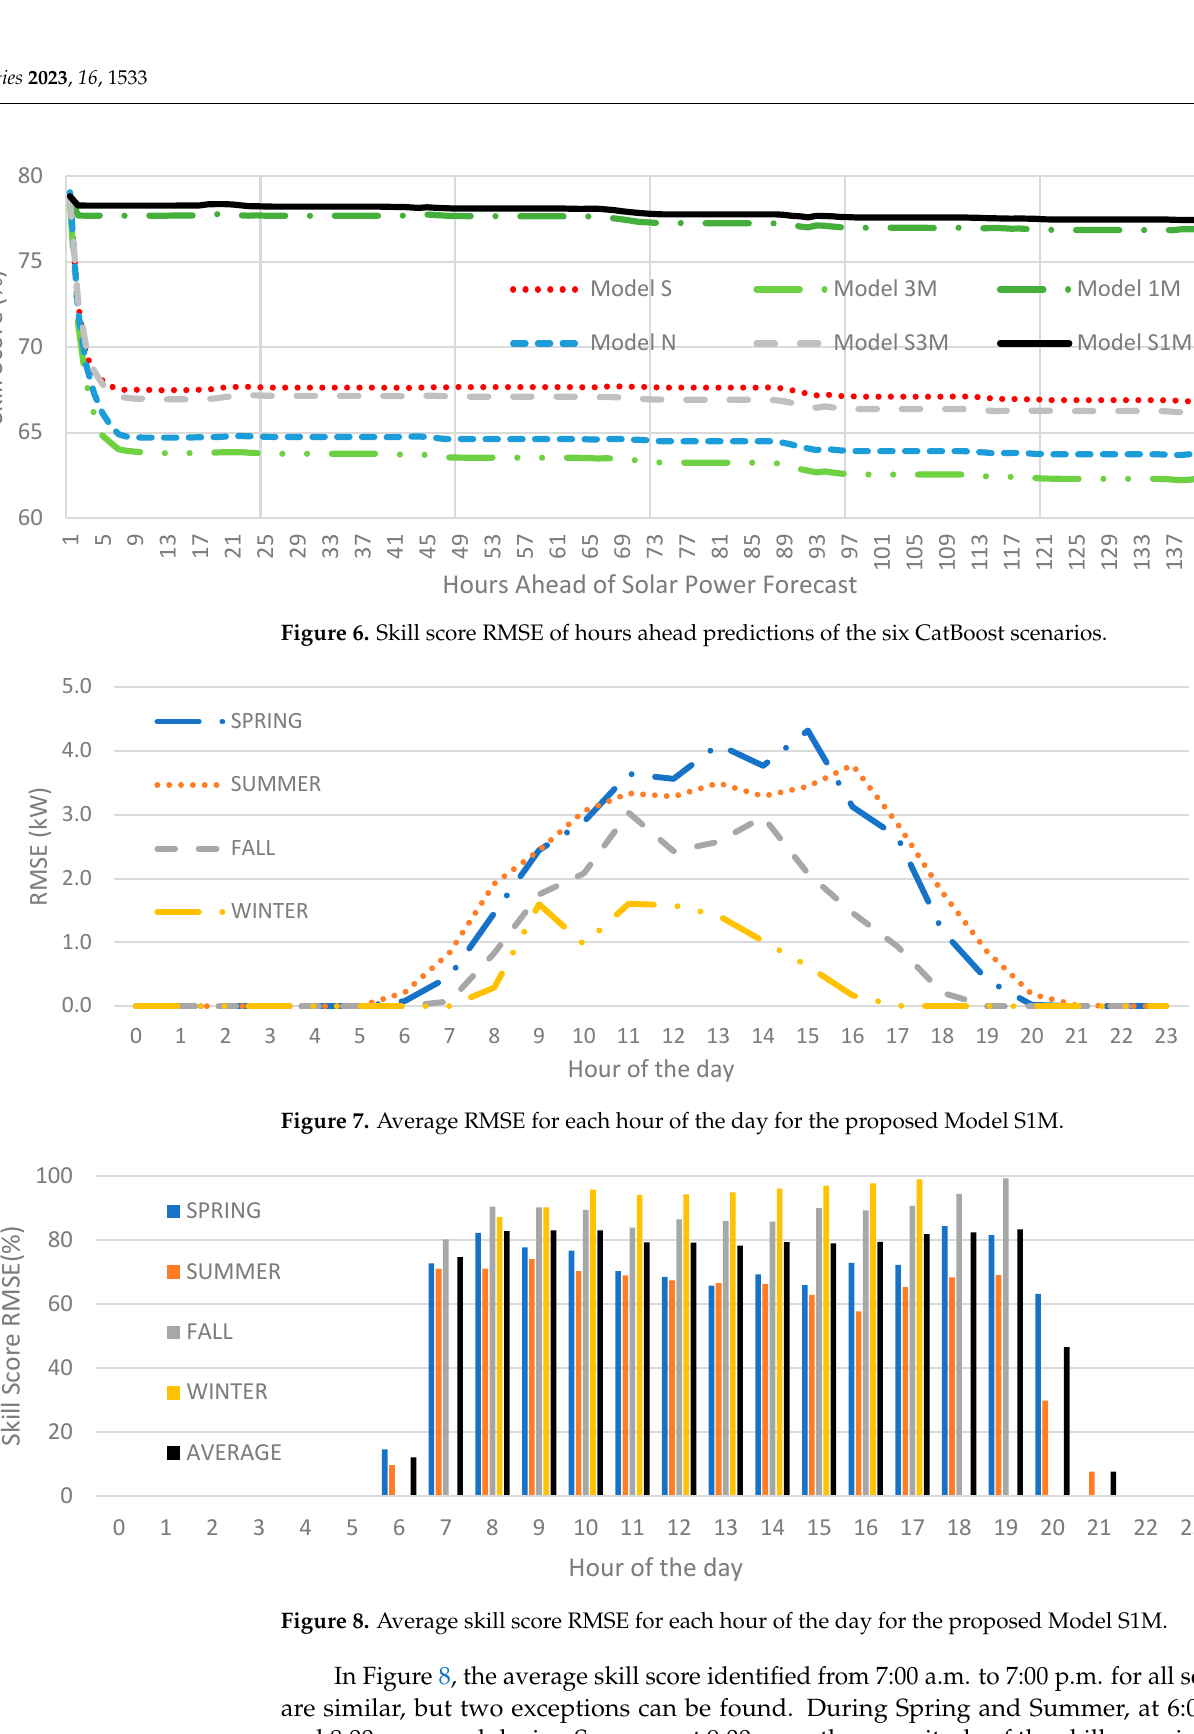
Figure 6. Skill score RMSE of hours ahead predictions of the six CatBoost scenarios.